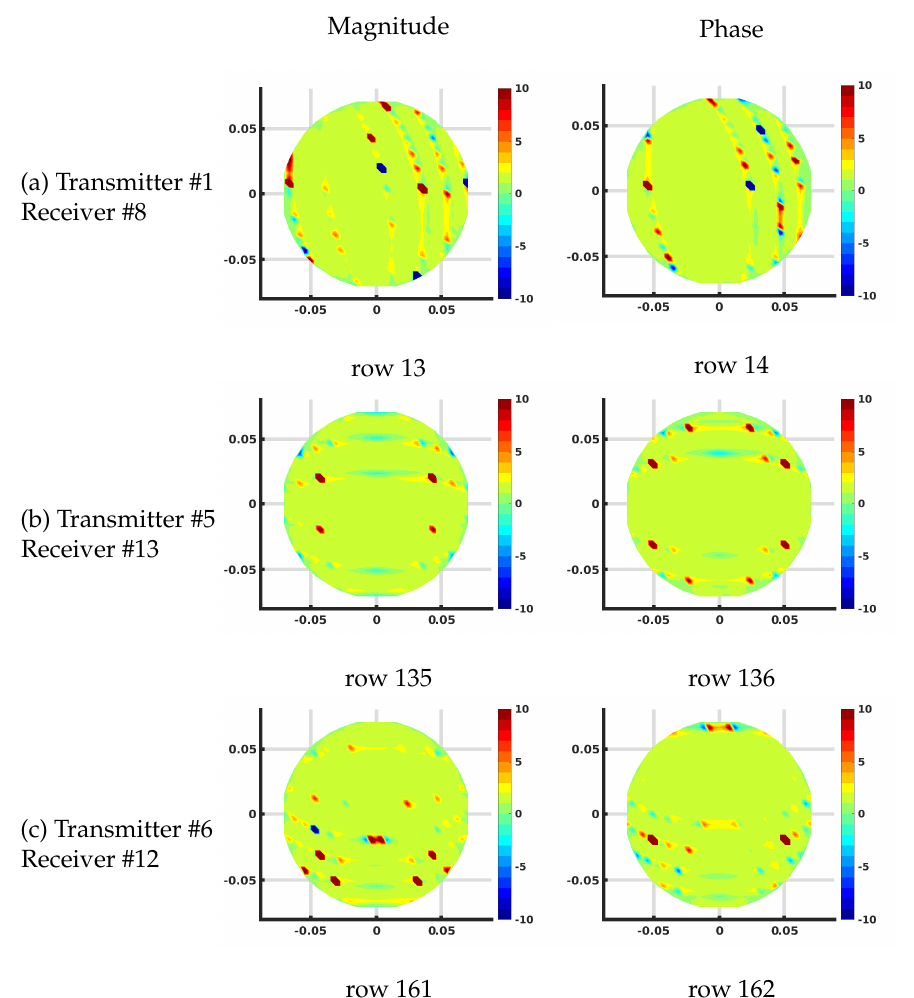
Figure 9. Plots of the effective log magnitude ( left ) and phase ( right ) distributions for ratios of Jacobian matrices calculated with DDA and FE-based schemes. The distributions are presented on the DDA